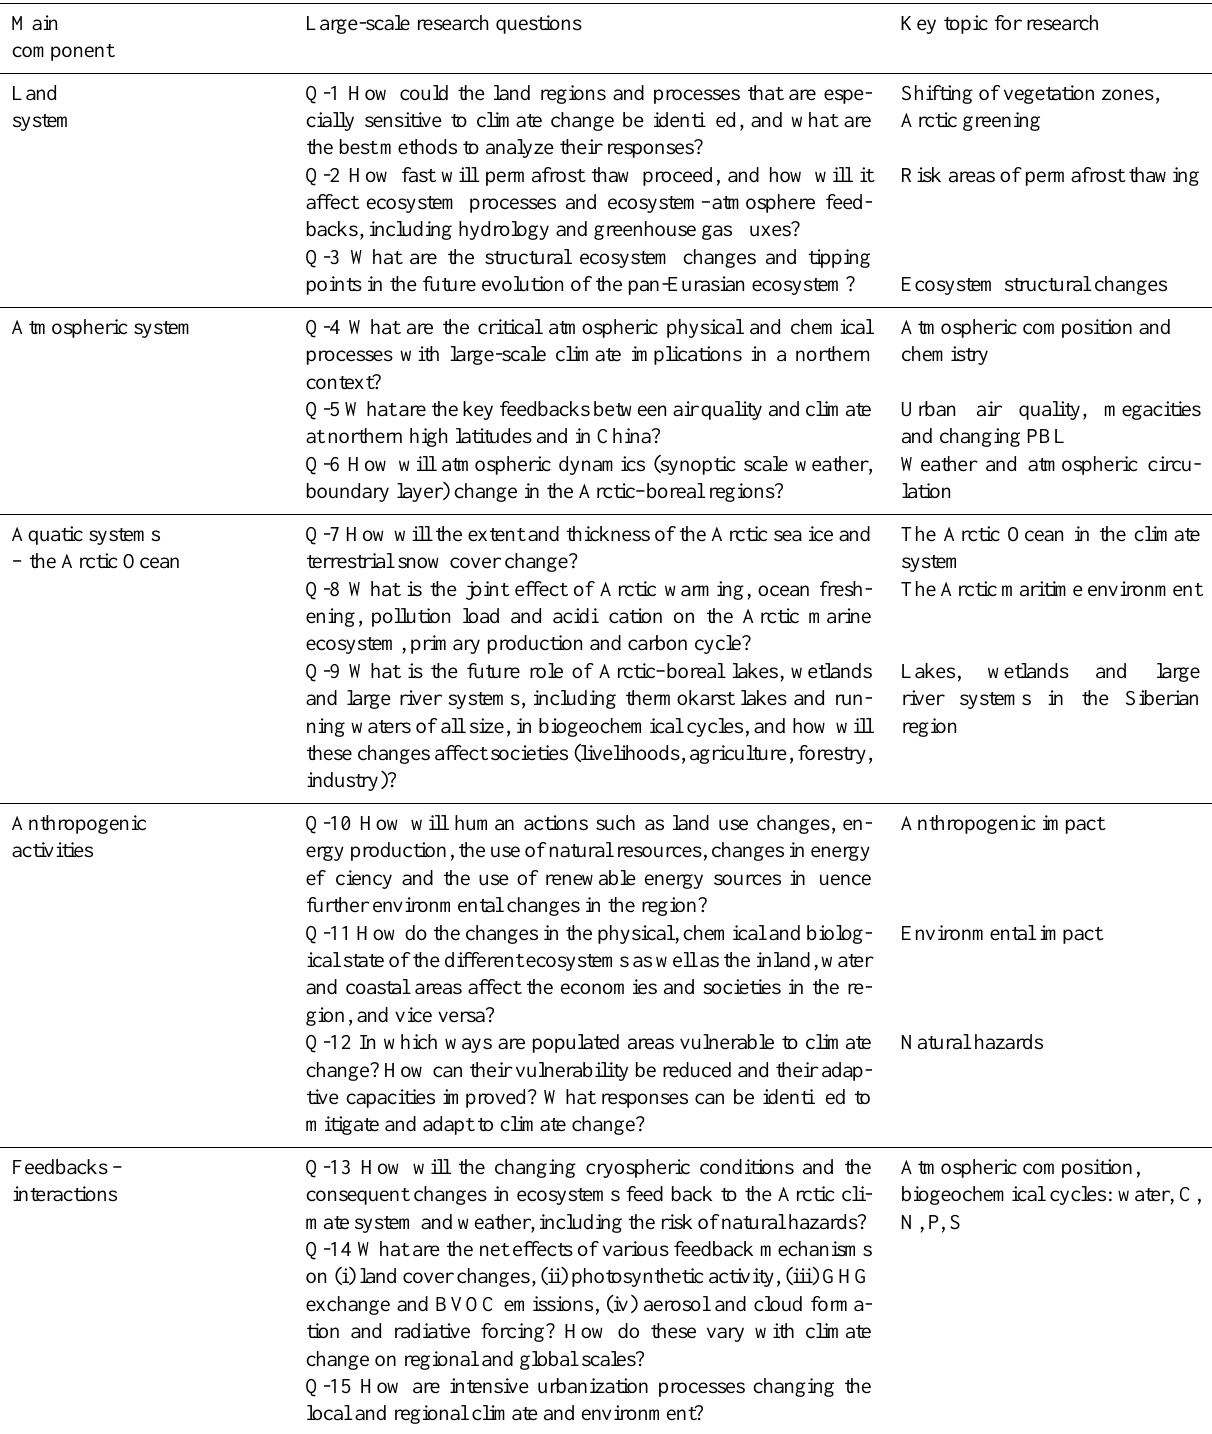
Table 1. List of PEEX – large-scale research questions. Main